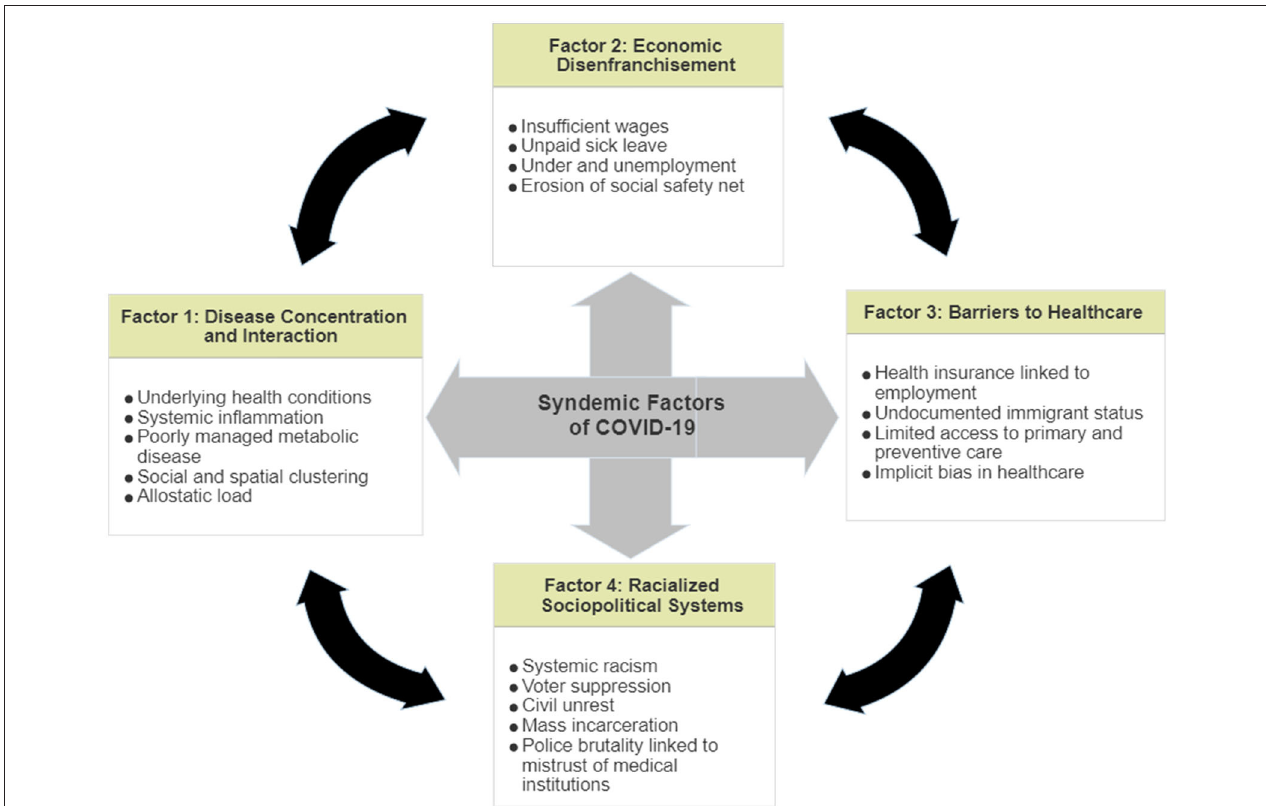
FIGURE 1 | COVID-19 syndemic